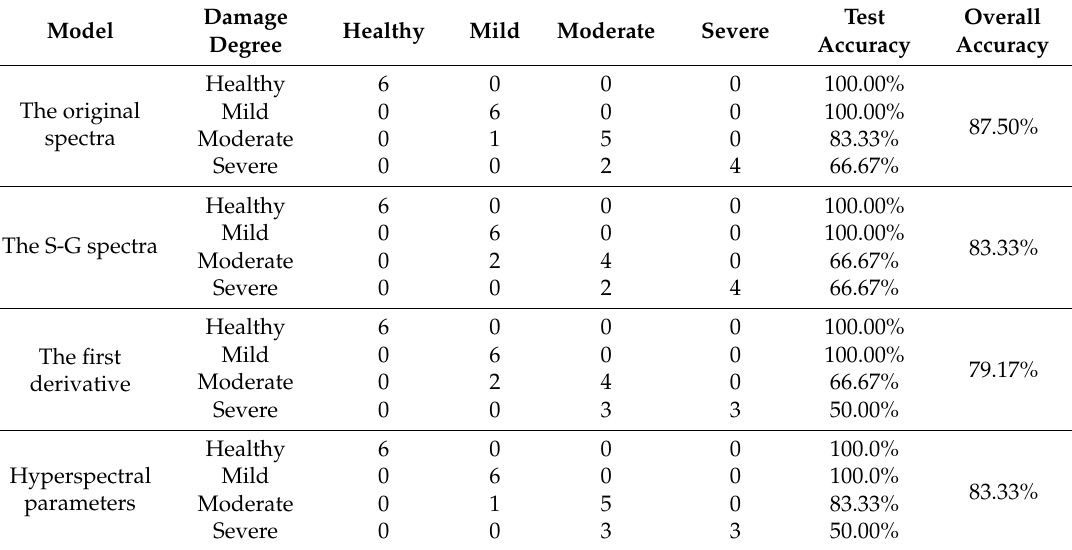
Table 12. Accuracy test results of the rules ( n =